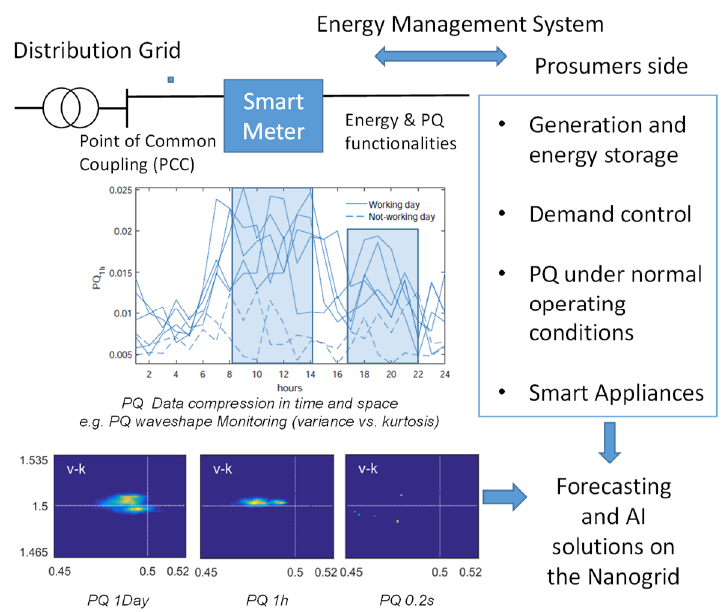
Figure 2. Energy and power quality (PQ) monitoring strategy, previous step to forecasting and artificial intelligence (AI) on the nanogrid [25].